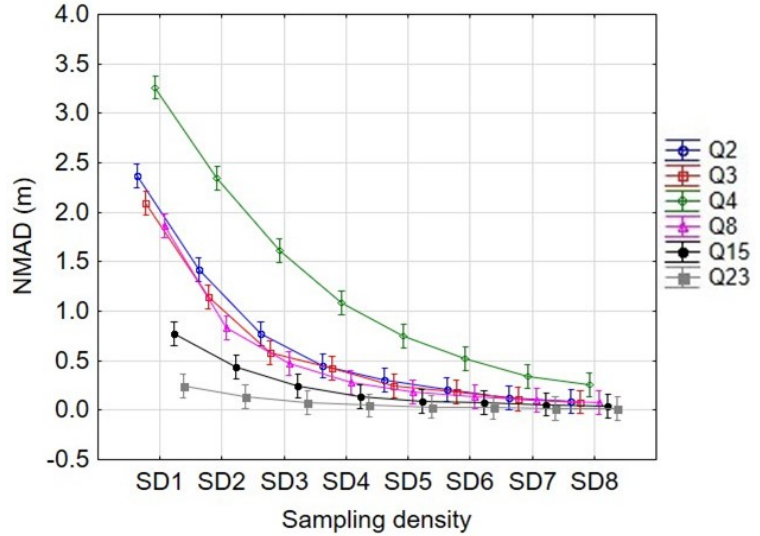
Figure 15. Plot of NMAD vs. Sampling Density factor for each morphology surveyed (interaction between SD and M factors). Vertical bars denote 95% confidence intervals.